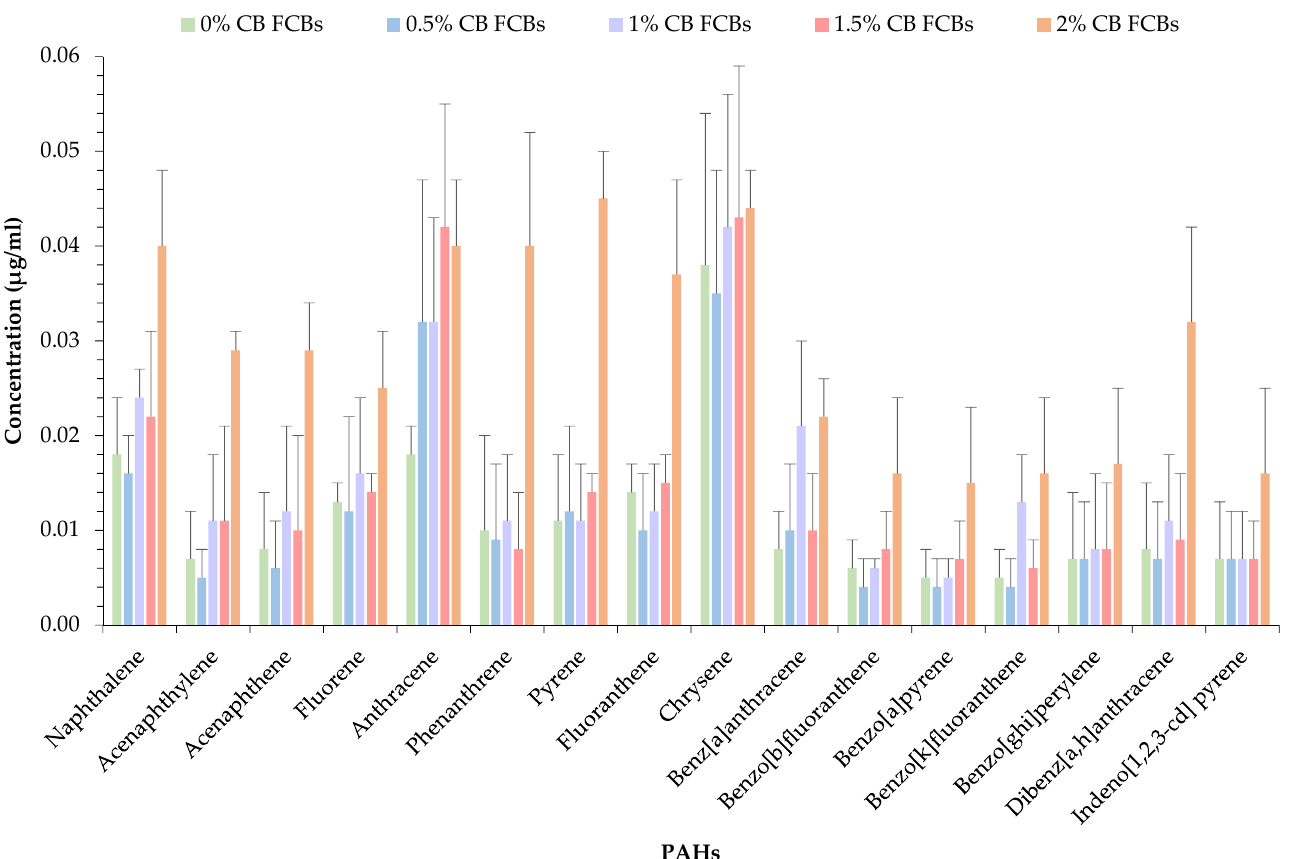
Figure 4. Results of PAHs found in FCBs incorporating 0%, 0.5%, 1%, 1.5%, and 2% CBs. The sample with the highest Σ PAH concentration was in the FCB samples